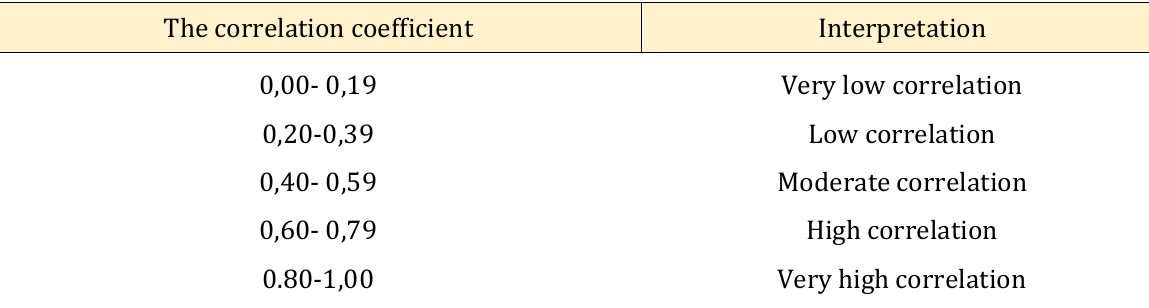
Table 6. The Magnitude of